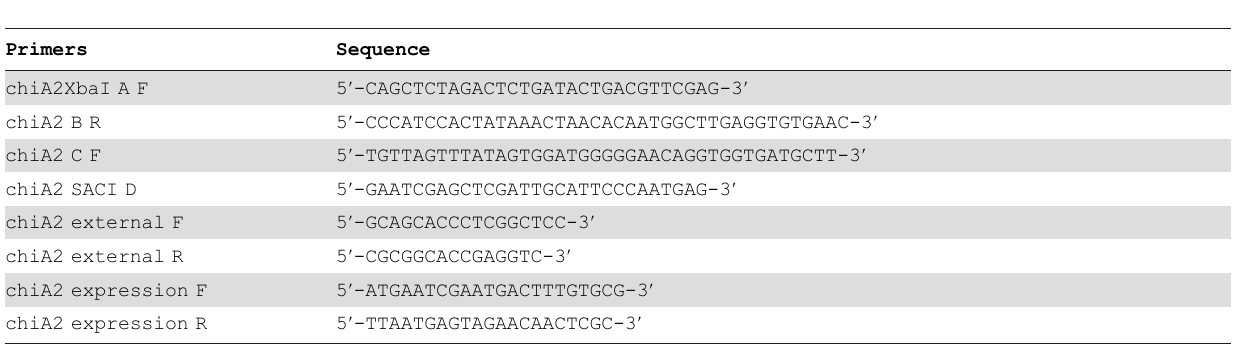
Table 1. List of Primers used in construction of chiA2 deleted V. cholerae strain and cloning chiA2 in pBAD-TOPO TA expression